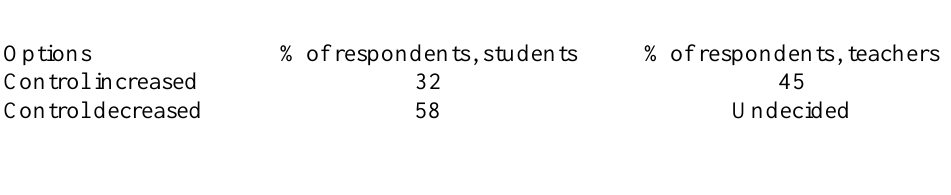
LMS as an Assessment Tool